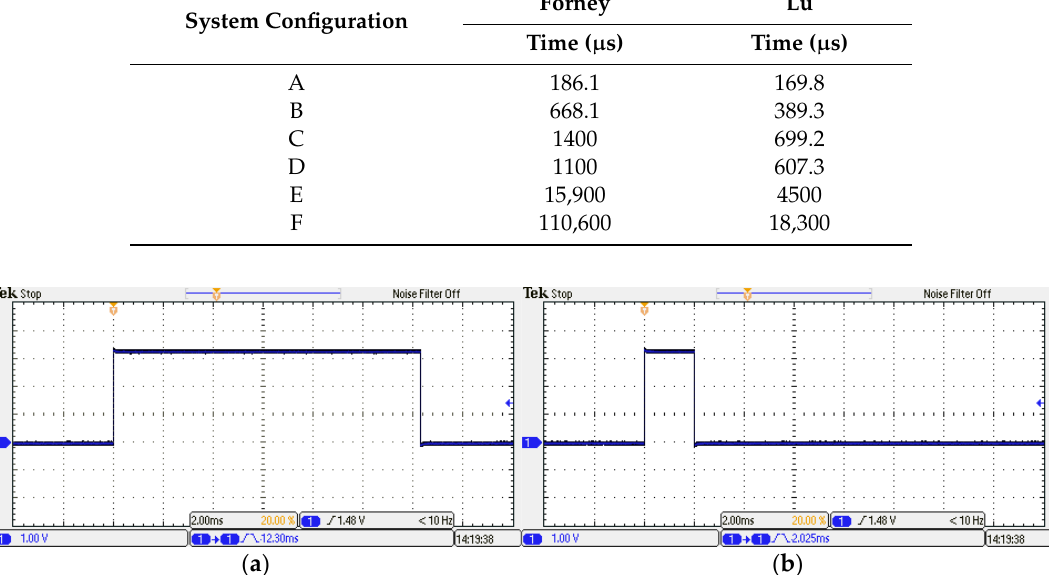
Figure 12. Oscilloscope measurements of the GPIO pin for the configuration F of Table 3 in the case of MCU implementation. ( a ) Measurement of the execution time of Forney’s algorithm, ( b ) Measurement of the execution time of Lu’s method.